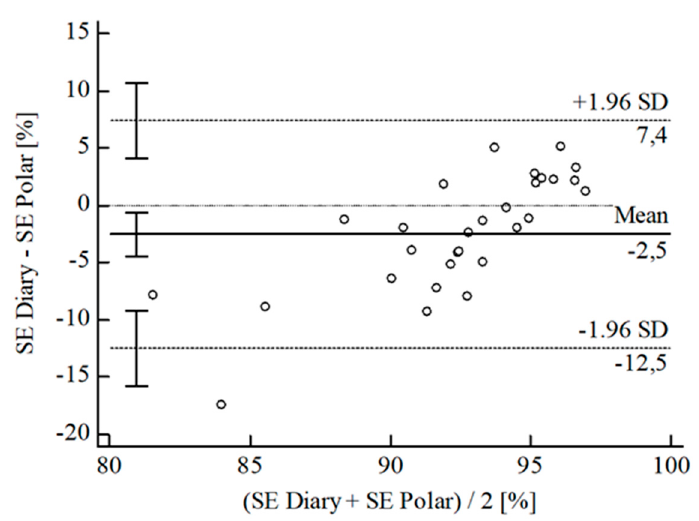
Figure 10. Bland-Altman plot for SE Garmin ® vs. diary.